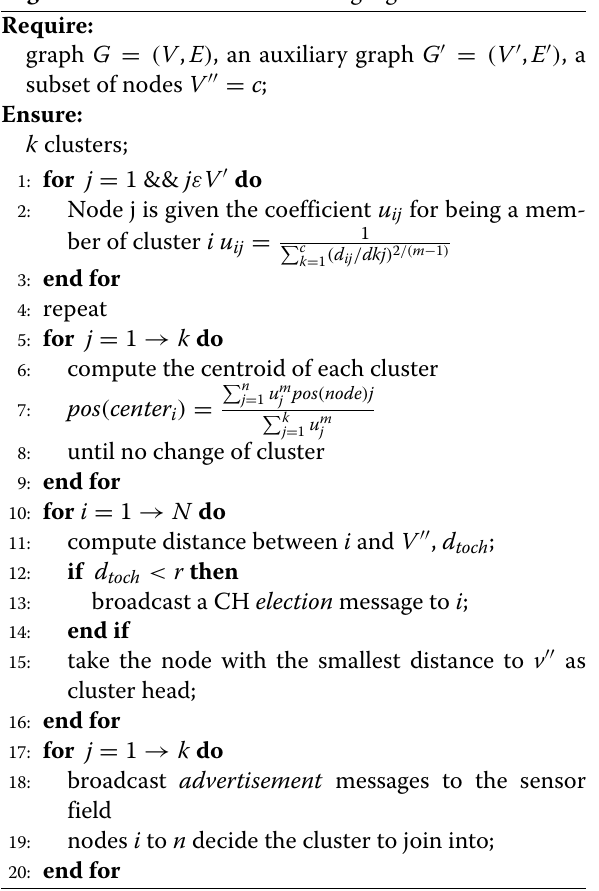
Algorithm 2 Distributed clustering